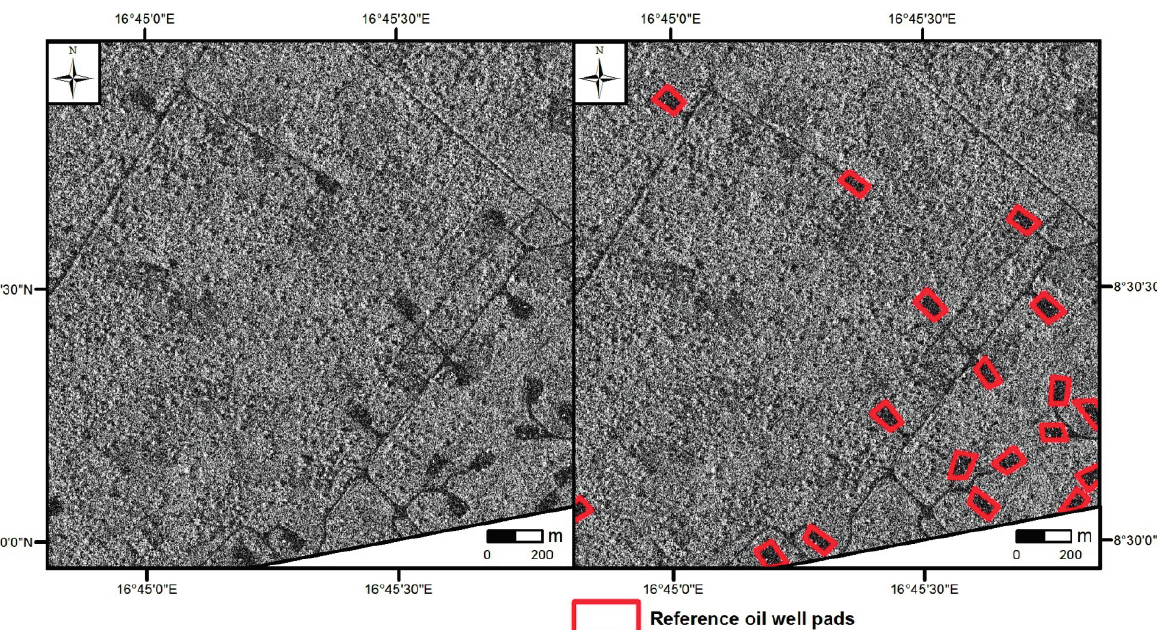
Figure 2. Subset of the study area. TerraSAR-X acquisition (5 September 2010) ( left ); Reference dataset marking the features of interest ( right ), i.e. , the oil well pads. The reference oil well pads were generated by manual digitalization. TerraSAR-X © 2014 German Aerospace Center (DLR), 2014 Airbus Defence and Space/Infoterra GmbH.